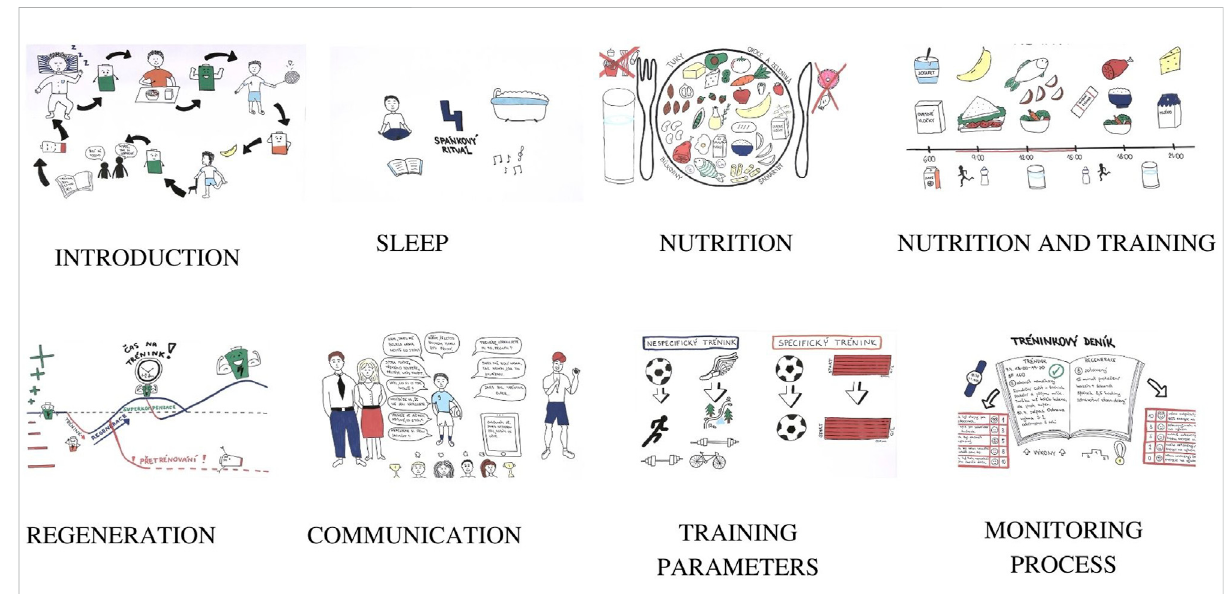
FIGURE 3 The educational part of the app: amination videos related to training demands and recovery (https://www.youtube.com/playlist?list=